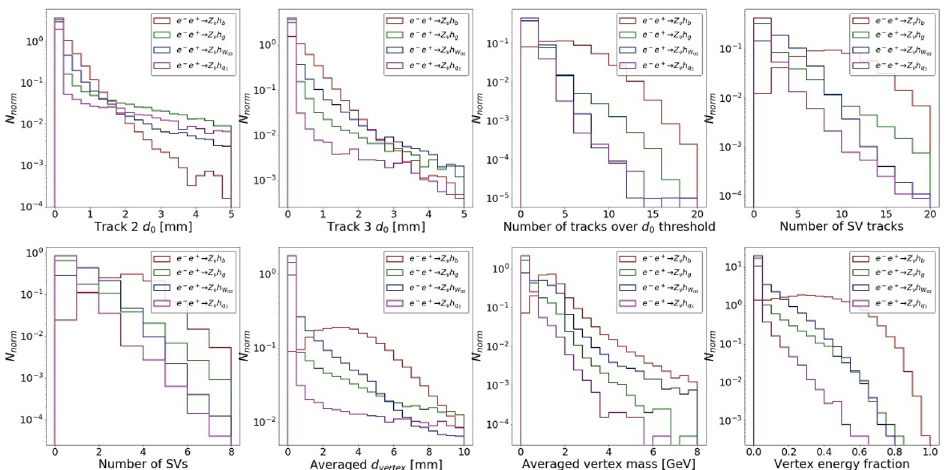
Figure 7 . Normalized distributions of the (SV) track observables for the two-jet samples. Here the tracks in each event are sorted ascendingly with the impact parameter d 0 . The d 0 threshold is set to be 0.5 mm. The vertex energy fraction is de(cid:12)ned w.r.t. the total (PV + SV) track